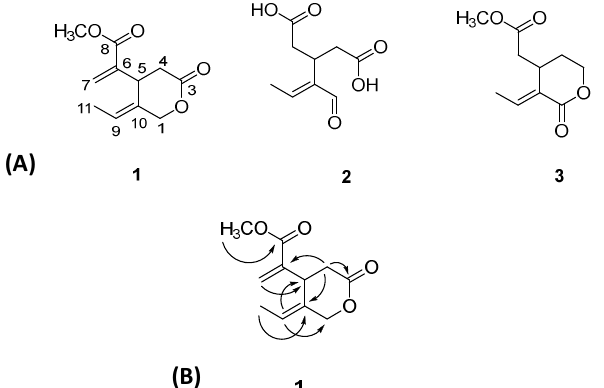
Figure 1. ( A ) Chemical structures of compounds 1 – 3 of L. lucidum fruits and ( B ) Key HMBC ( → ) correlations of new compound 1.